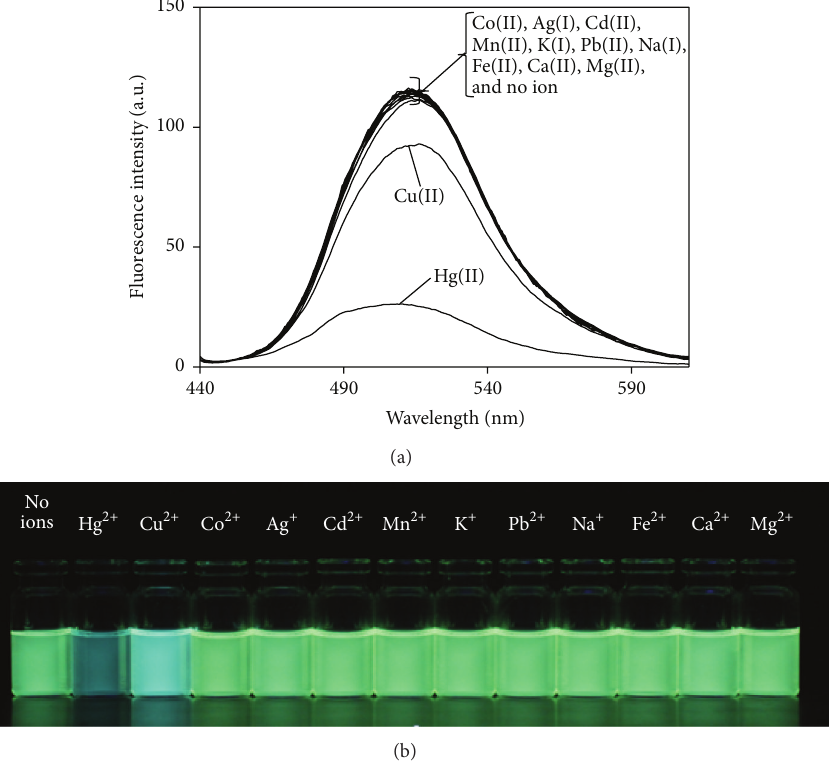
= 426 nm, 0.15 𝜇 M) with addition of perchlorate salts of Hg 2+ , Co 2+ , Ag + , Cd 2+ , Mn 2+ , K + , Pb 2+ , Figure 6: (a) Fluorescence spectra of 1 ( 𝜆 ex Na + , Fe 2+ , Ca 2+ , Mg 2+ , and Cu 2+ , (123 𝜇 M). (b) The luminescence under a UV of 1 (2.3 𝜇 M) in the presence and absence of Hg 2+ , Cu 2+ , Co 2+ , Ag + , Cd 2+ , Mn 2+ , K + , Pb 2+ , Na + , Fe 2+ , Ca 2+ , and Mg 2+ (3.0 𝜇 M).